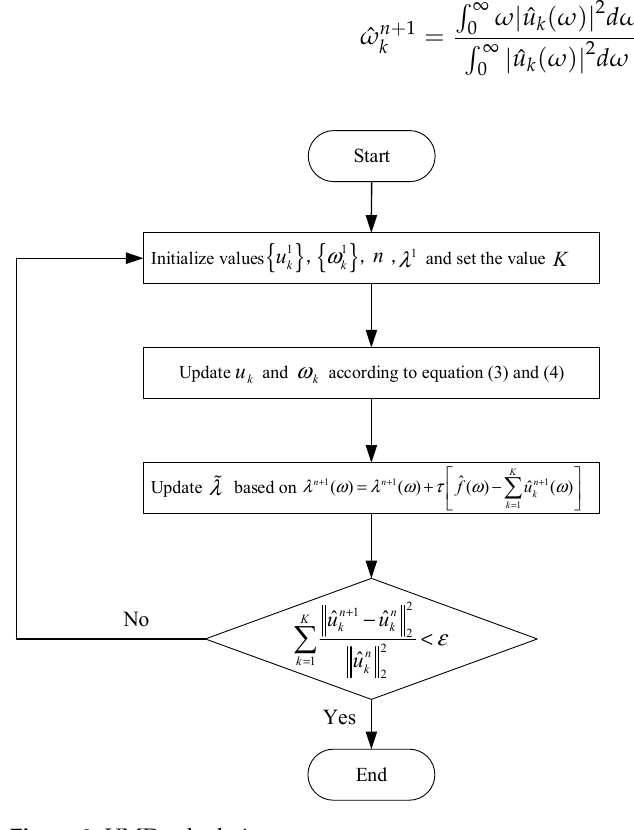
Figure 2. VMD calculation process.